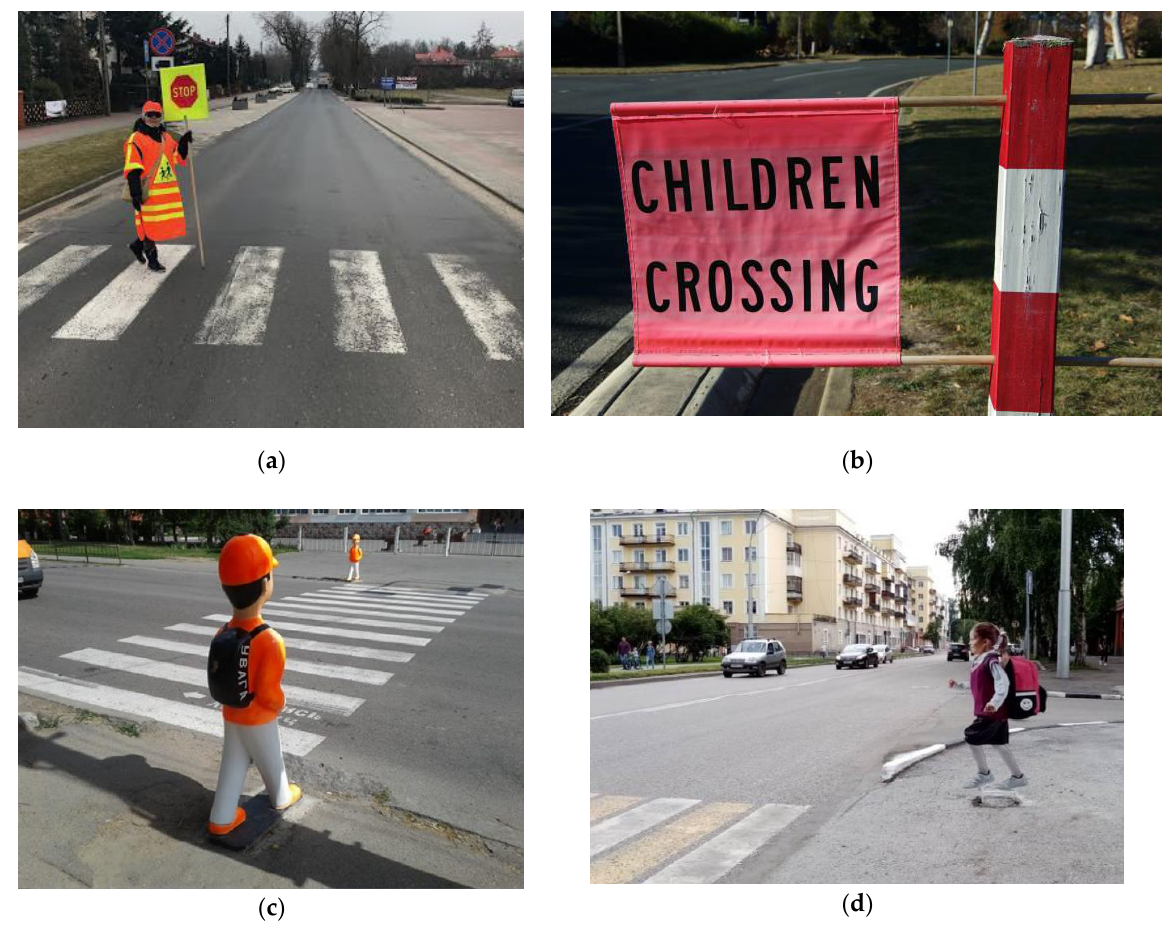
Figure 9. Exemplary solutions increasing the safety of children at school crossings: ( a ) Children’s crossing guard. Reprinted with permission from ref. [47]. Copyright 2017 Urząd Miejski w Wolborzu [47], ( b ) Children’s crossing. Reprinted with permission from ref. [48]. Copyright: Simon McGill (Getty Images), ( c ) A plaster figure imitating a road-crossing child. Reprinted with permission from ref. [49]. Copyright 2017 Depo.ua, ( d ) Plastic model of a girl crossing the road. Reprinted with permission from ref. [50]. Copyright 2020 Екатерина Романова ( Комсомольская правда ).